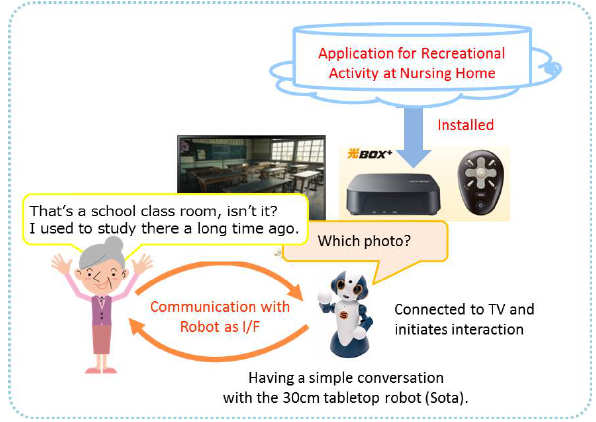
Figure 1. System